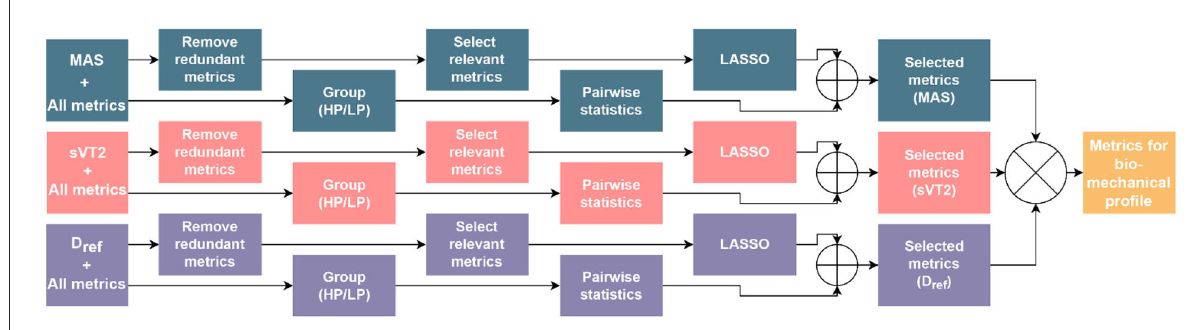
FIGURE3 Procedure for selection of performance metrics for the biomechanical